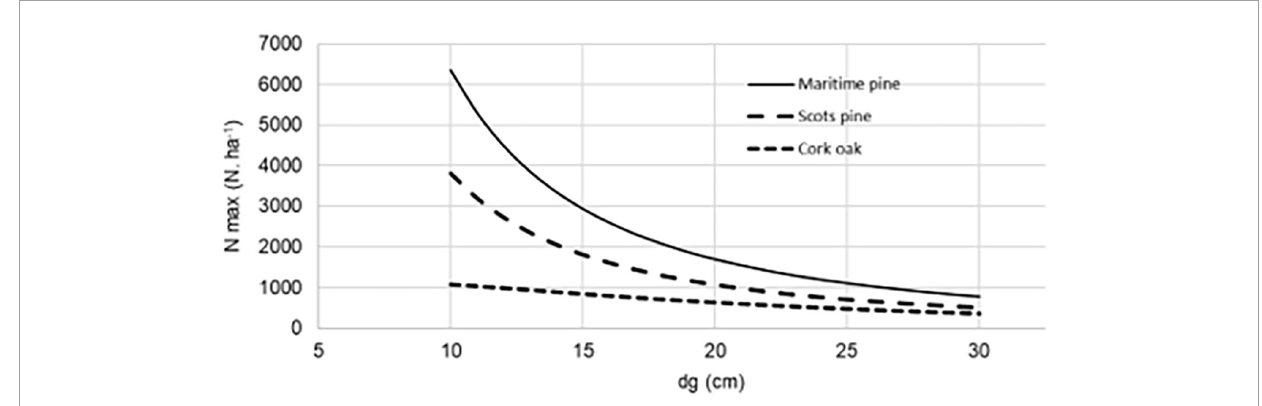
FIGURE6 Changes in number of trees over time in pure monospecific even-aged